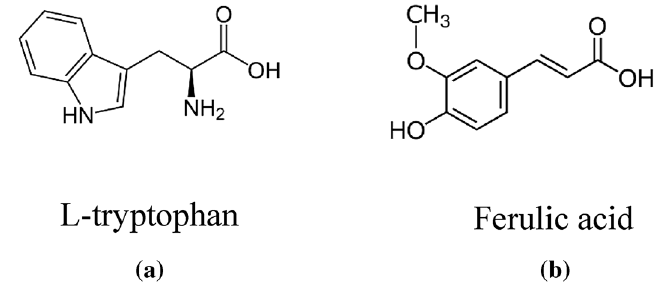
Figure 2. Major chemical constituents of ( a ) Fen and ( b ) CgL extracts.